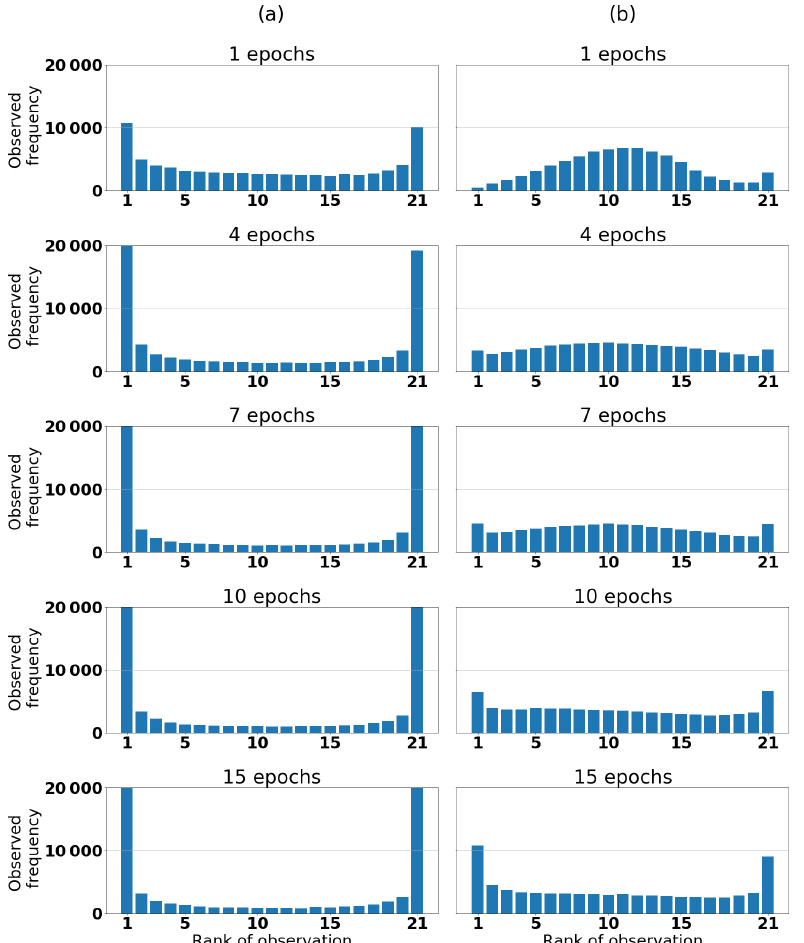
Figure 6. Rank histogram for different numbers of epochs (a) with snow density and (b) SWE as the target variables. We use the reference setup presented in Table